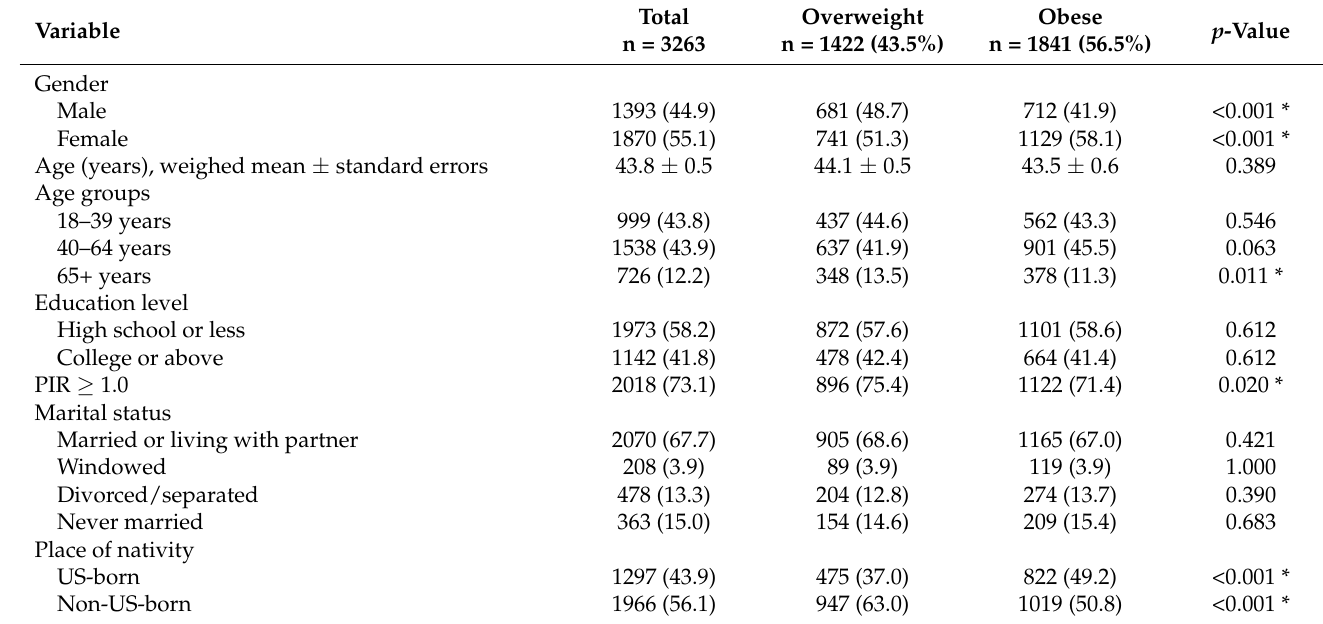
Table 1. Characteristics of respondents aged 18+ stratified by weight status, NHANES